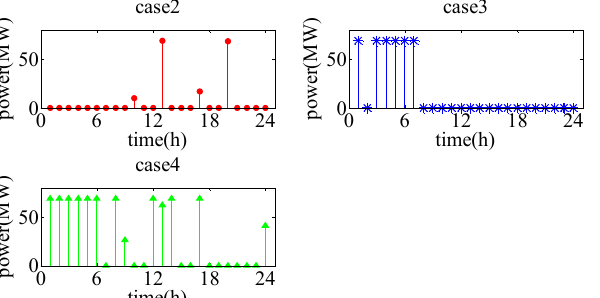
Figure 7. Input power of P2H equipment in Cases 2–4. In the figure, the red circulars, the blue asterisks and the green triangles, respectively, represent the input power of the P2H equipment in Case 2, Case 3 and Case 4.